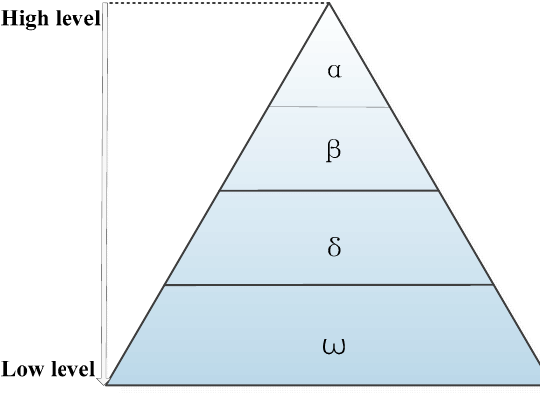
Figure 1. The hierarchy of grey wolves.